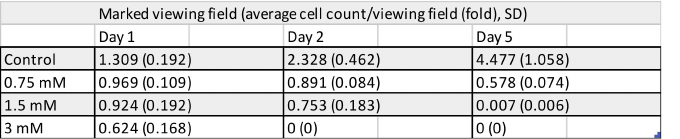
Figure 2. Number of viable pulp cells at various time-points of the 5-day exposure to 0.75, 1.5, and